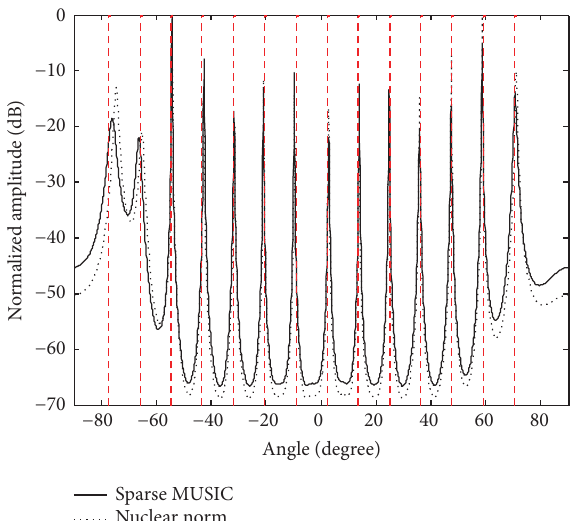
Figure 7: Spatial spectrums of Sparse MUSIC and nuclear norm (𝐾 = 14) .